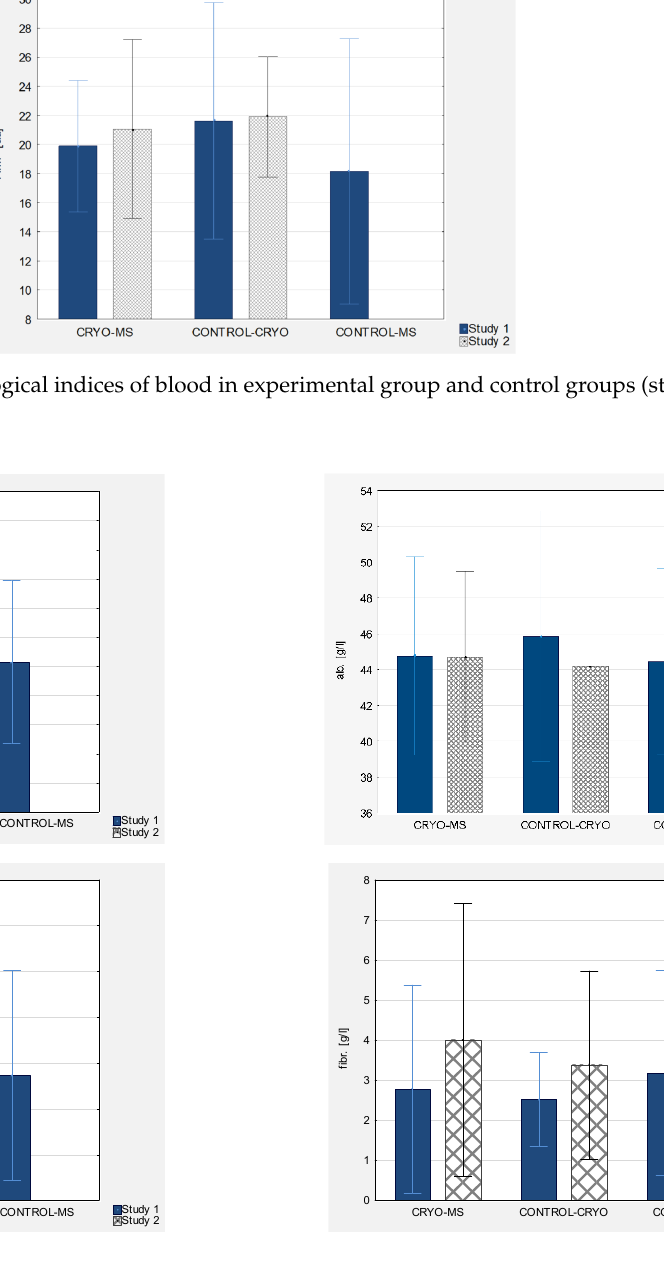
Figure 4. Biochemical indices (total protein, albumin, gamma globulin, fibrinogen) of blood in experimental group and control groups (study 1 and study 2, respectively). Table 2. ANOVA results: baseline parameters (before WBC).